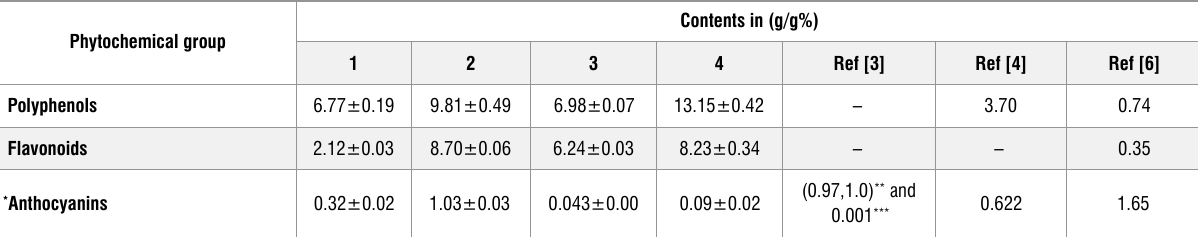
Table 3: Quantitative analysis of polyphenol, flavonoid, and anthocyanin contents (in g/g%) in methanolic extracts of roselle